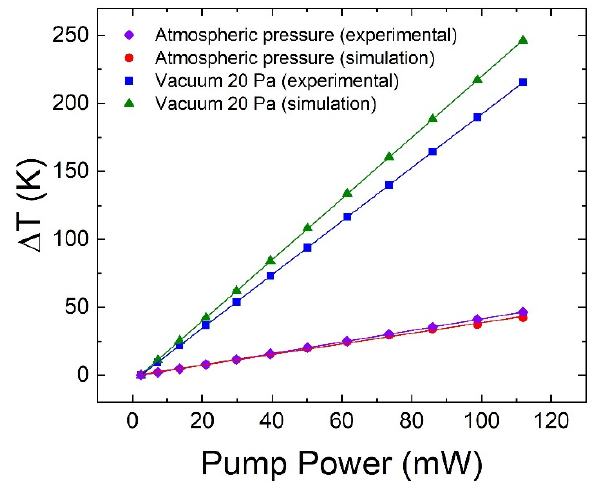
Figure 7. Simulated and measured changes in temperature as a function of laser pump power for the microsphere at atmospheric pressure and at 20 Pa vacuum.